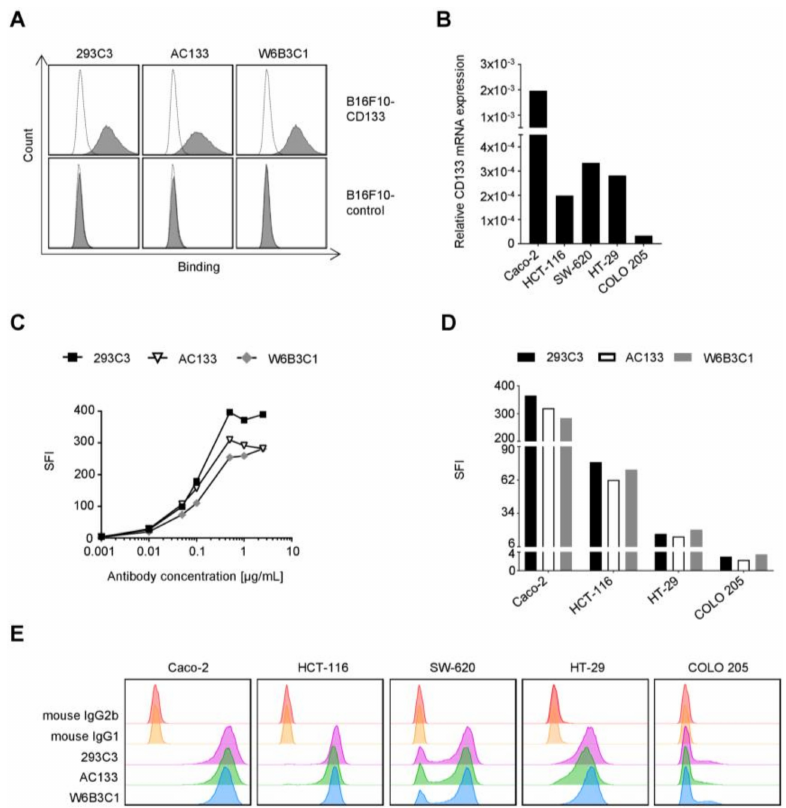
Figure 1. Comparative binding analysis of di ff erent CD133 monoclonal antibodies (mAbs) to colorectal cancer (CRC) cells. ( A ) Specific binding of three di ff erent commercially available CD133 mAbs (293C3,